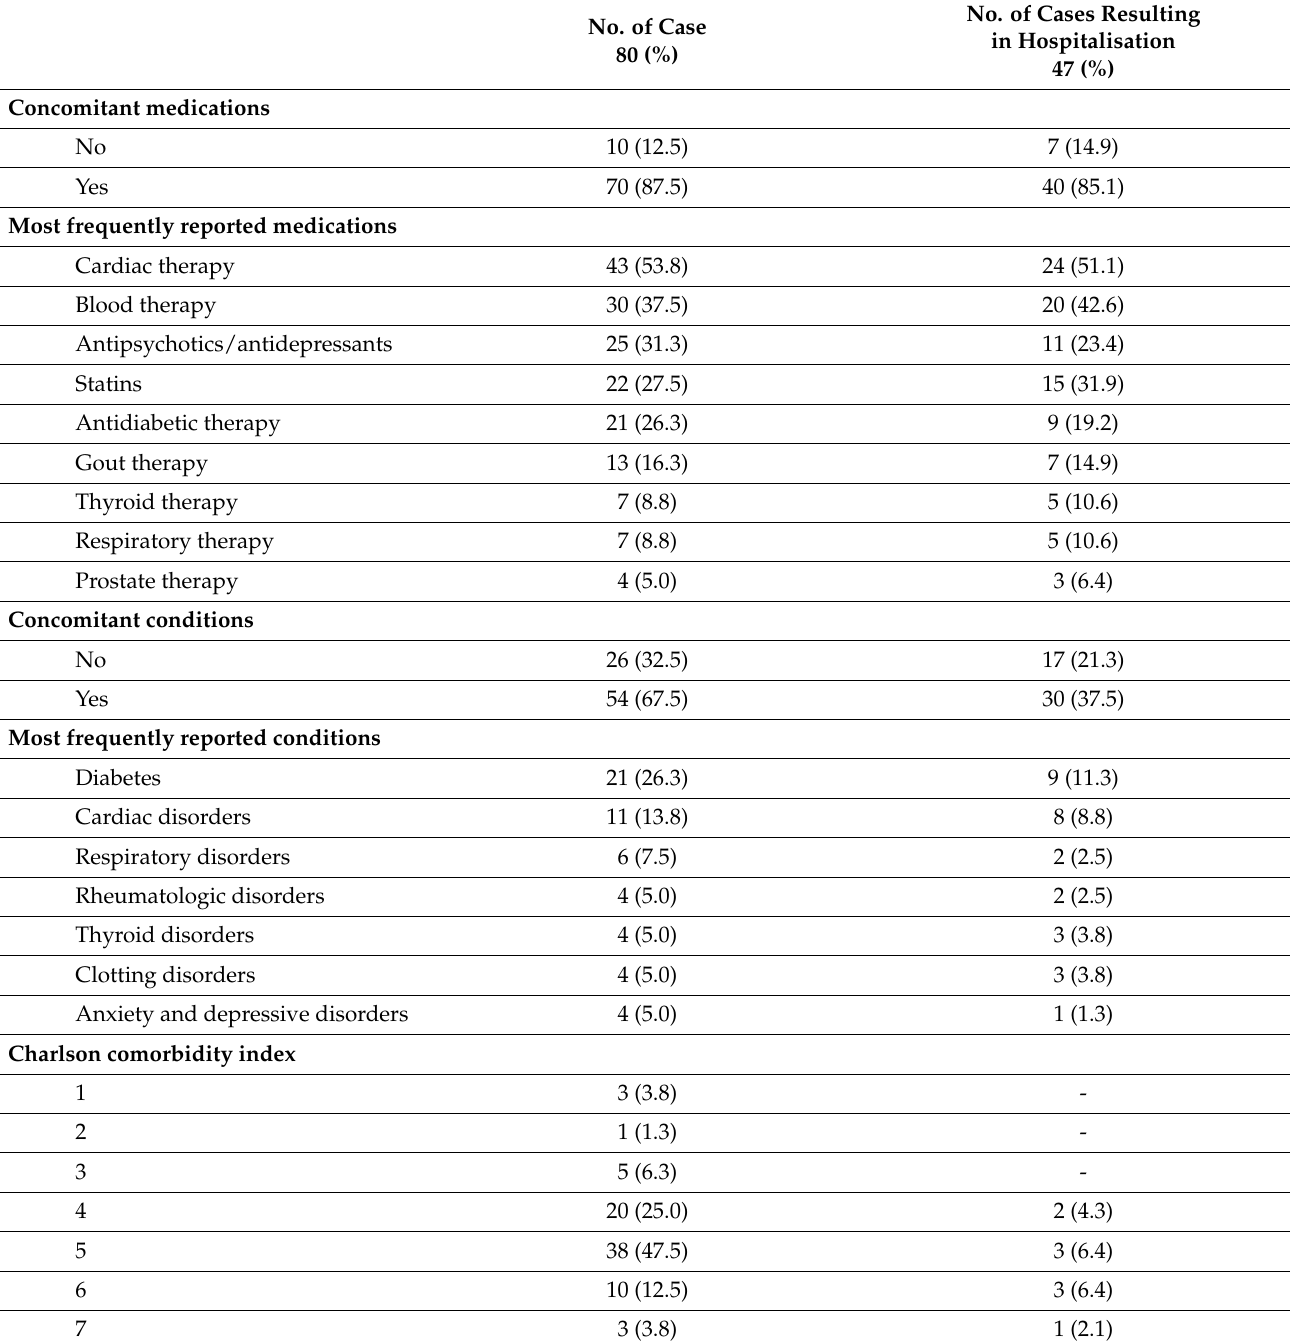
Table 3. Concomitant medications and